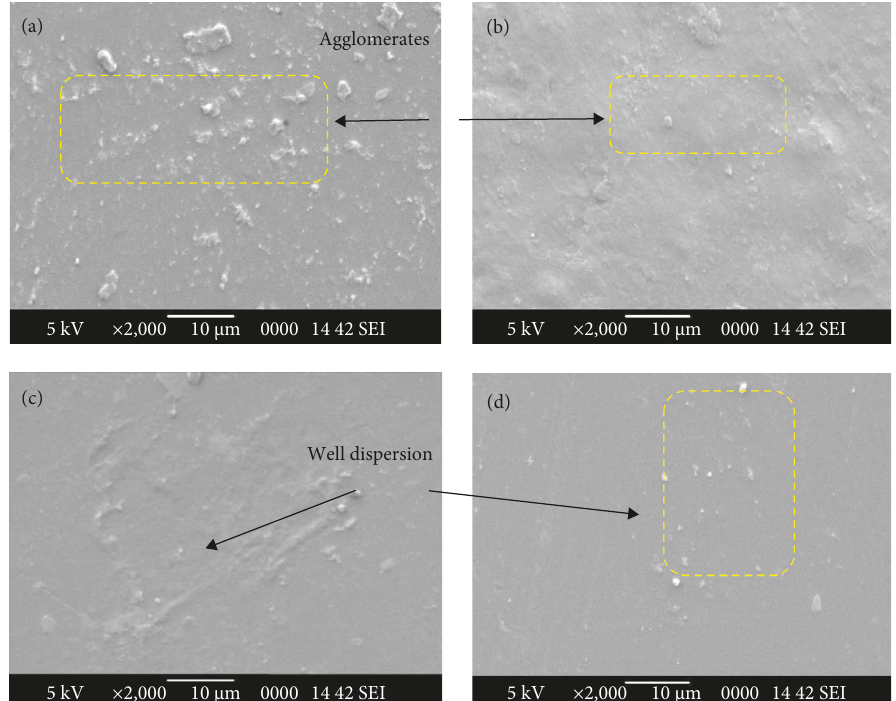
Figure 5: SEM images showing the degree of zirconia filler dispersion as a function of mixing time: (a) 4 minutes, (b) 5 minutes, (c) 6 minutes, and (d) 7